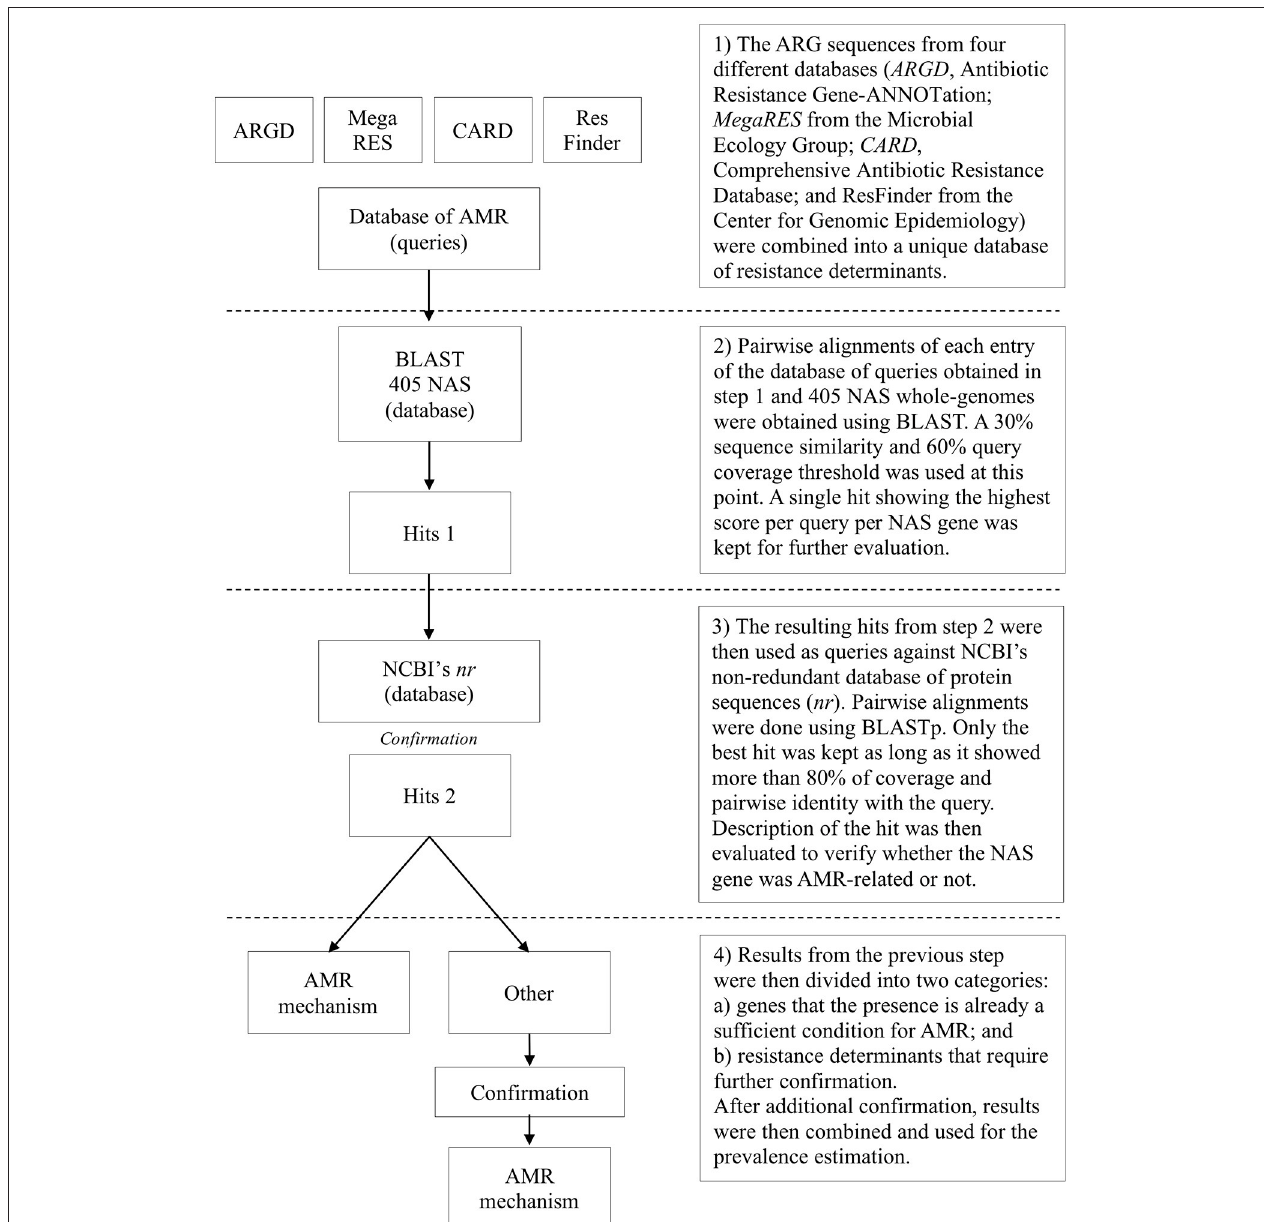
FIGURE 1 | Flow diagram for determining genetic elements associated with antimicrobial resistance (AMR) in 405 bovine non- aureus staphylococci